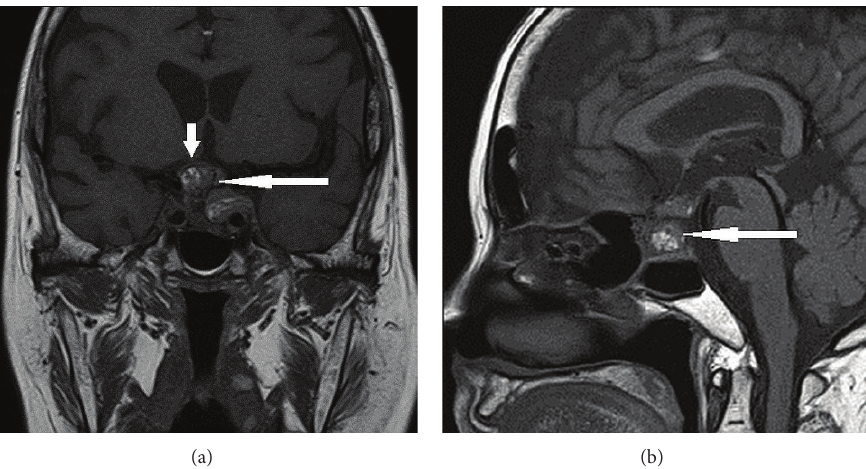
Figure 3: (a) MRI pituitary (T1-weighted, contrast, and coronal) showing pituitary mass (long arrow) with mass effect on the optic chiasm (short arrow). (b) MRI pituitary (T1-weighted, contrast, and sagittal) showing presence of increased signal intensity in the pituitary mass, representing presence of blood products (long arrow).